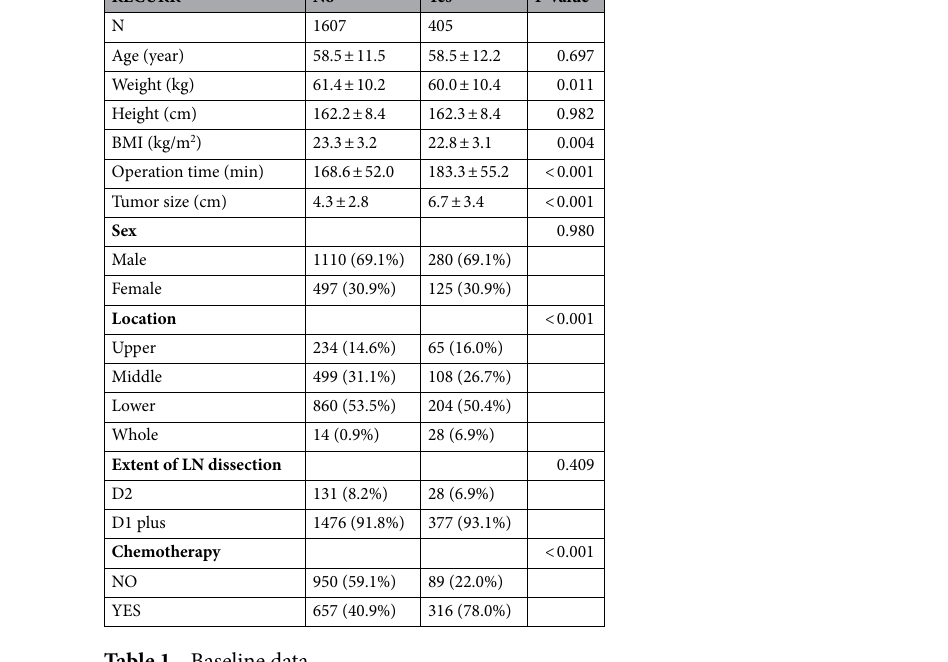
Table 1. Baseline